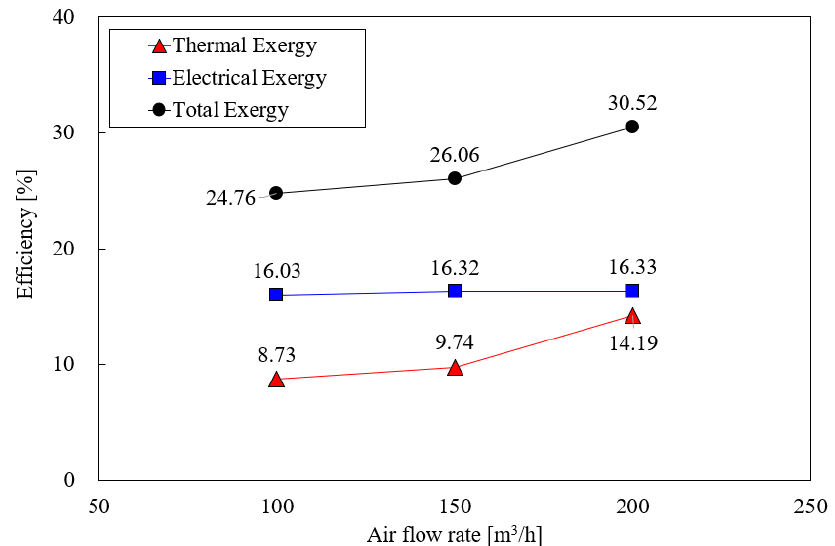
Figure 9. Exergy and energy efficiency by flow rate.